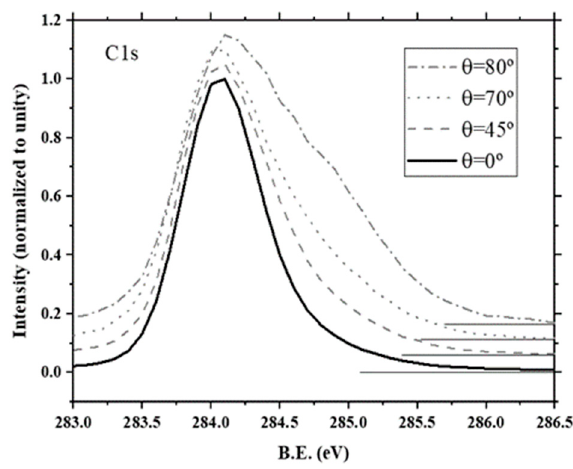
Figure 3. Normalized intensity ARXPS C 1s spectra of a (100)-oriented H-diamond for θ = 0°, 45°, 70° and 80° after background subtraction.